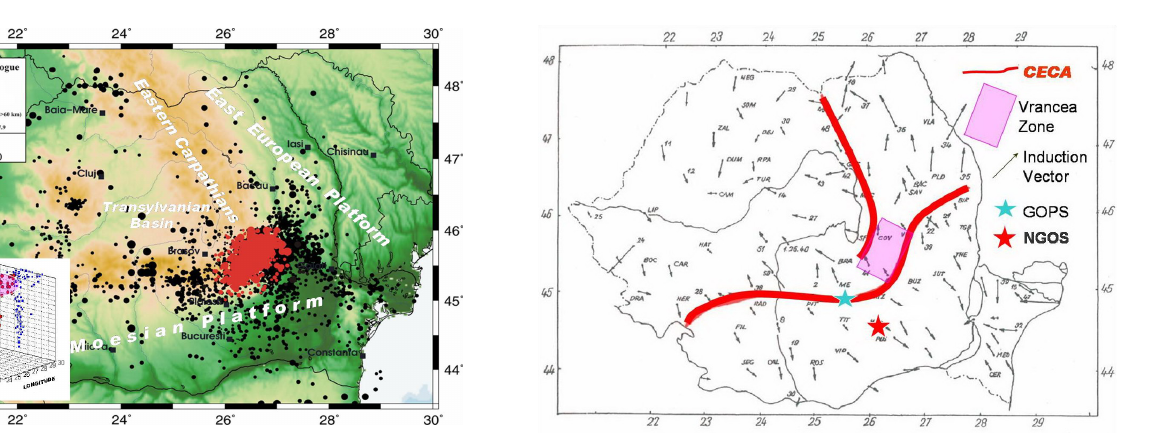
Fig. 1. Map of the seismic active Vrancea zone with crustal epicen- tres (black circles) and intermediate depth epicentres (red circles) earthquakes taken from ROMPLUS catalogue; the earthquakes foci for 2009 are shown in the lower left corner.